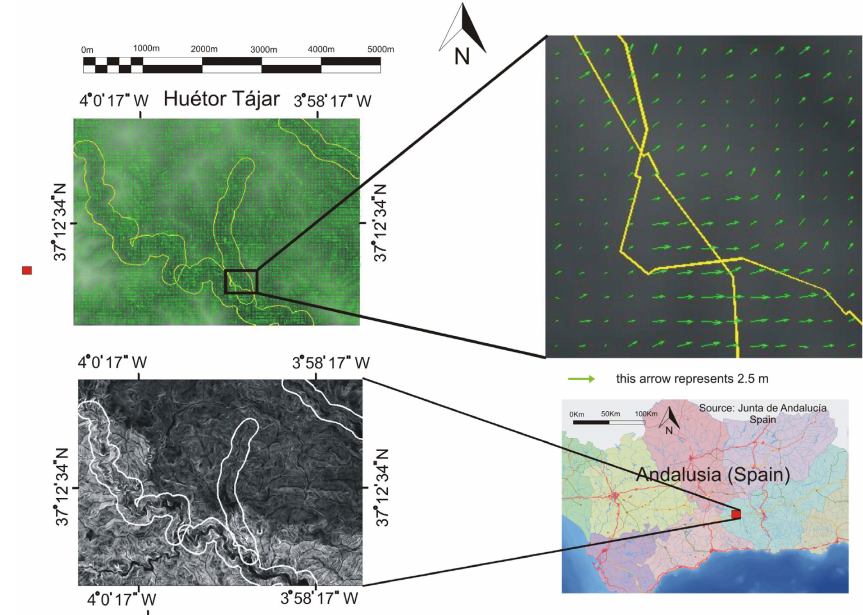
Figure 8. Horizontal displacement represented by vectors (green color). Detail from Colmenar